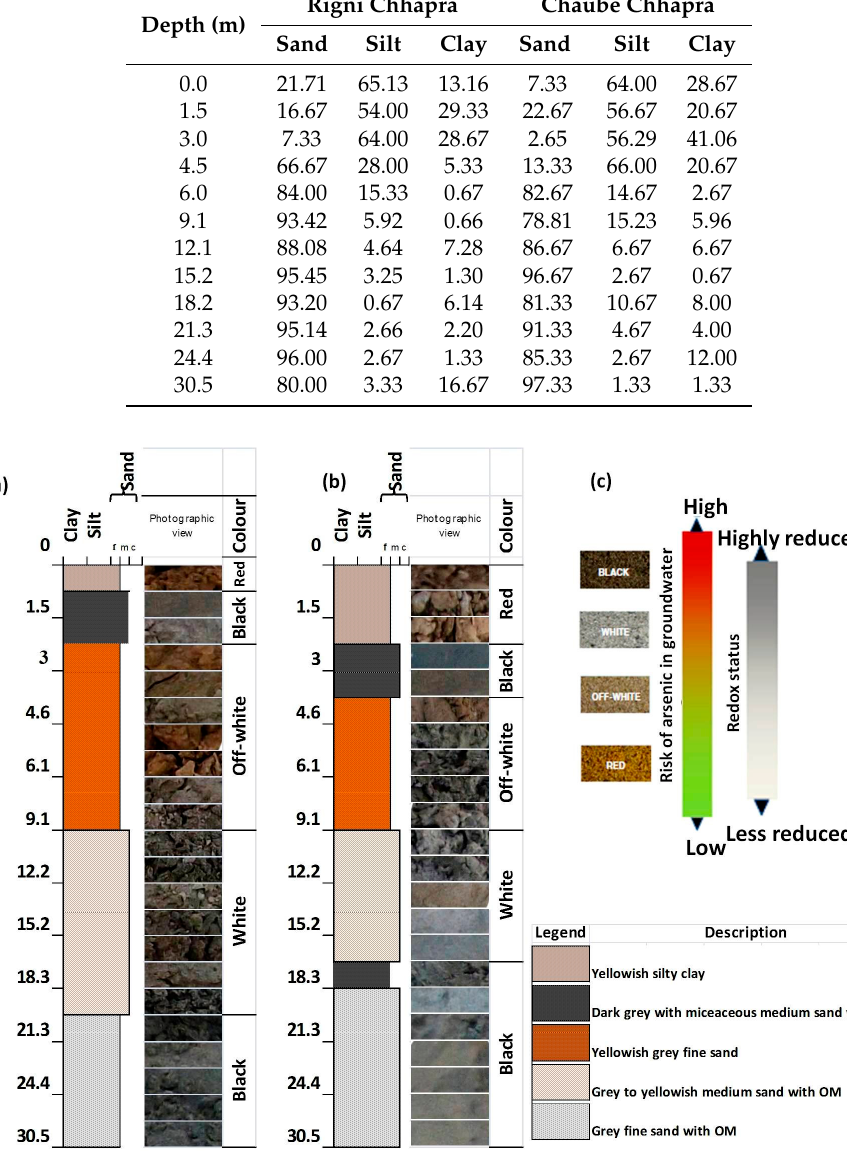
Figure 2. Lithologs prepared from core profile samples along with their corresponding fresh sediments photographic view ( a ) Rigni Chhapra ( b ) Chaube Chhapra ( c ) Four color sands with corresponding risks of As concentration in groundwater under varying redox status adopted from reference